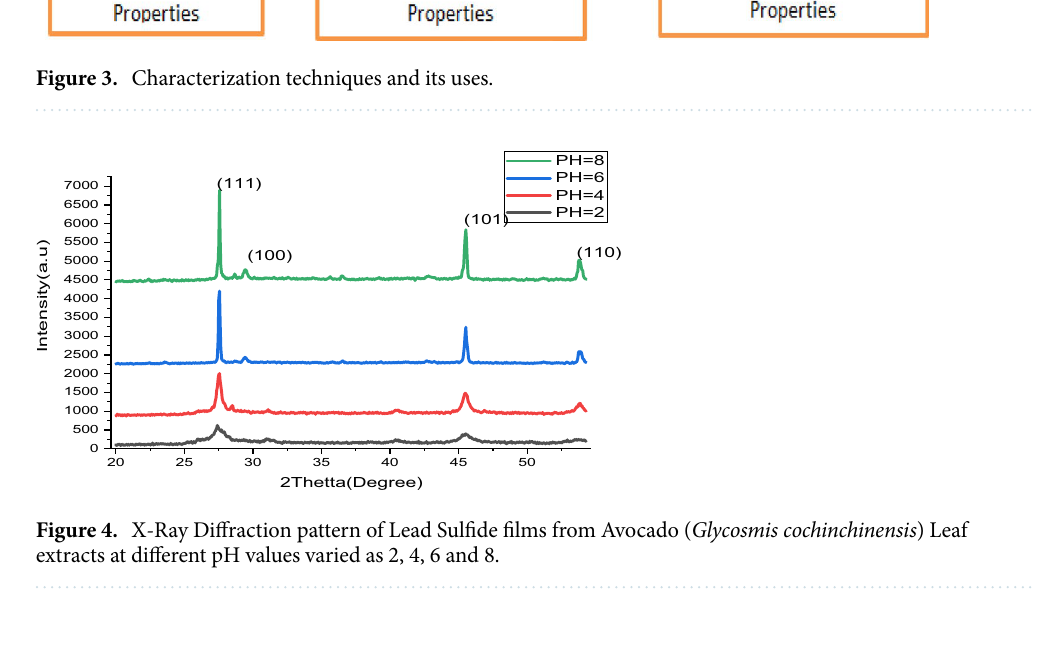
of thin films prepared through CBD techniques 37 .